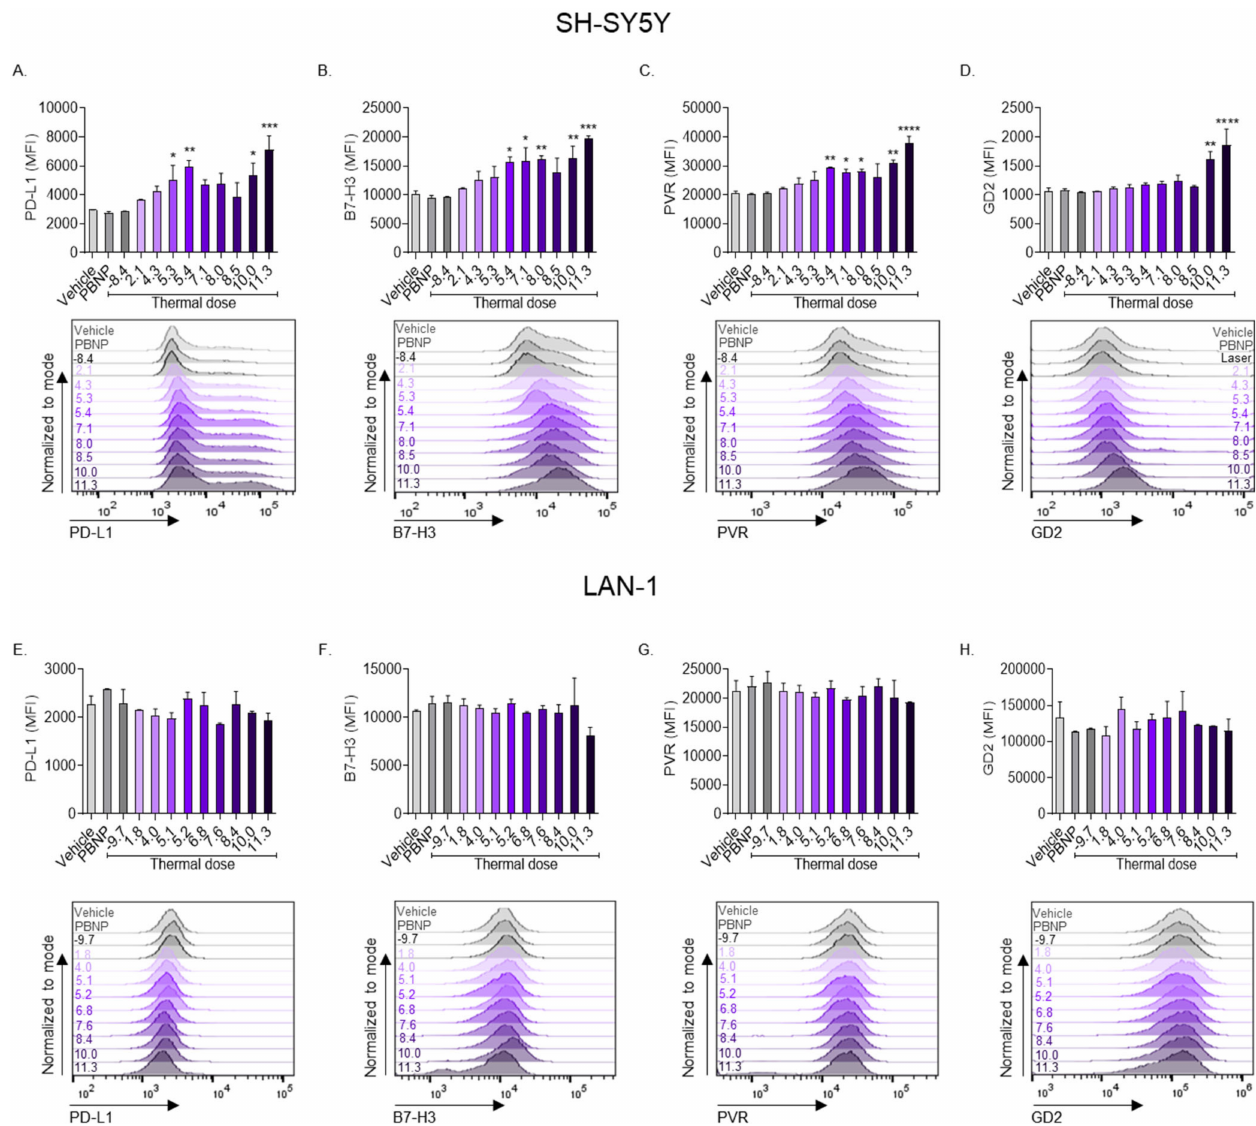
Figure 5. The effect of PBNP-PTT-administered thermal dose on immune checkpoint molecules, an NK cell-activating ligand, and a neuroblastoma-associated antigen is more pronounced in SH-SY5Y cells compared with LAN-1 cells. ( A – D ) SH-SY5Y and ( E – H ) LAN-1 cells were treated in vitro with varied thermal doses via PBNP-PTT. 24 h post-PBNP-PTT, cells were analyzed for expression of ( A , E ) PD-L1, ( B , F ) B7-H3, ( C , G ) PVR, and ( D , H ) GD2 using flow cytometry analysis. Inset values in the histograms denote the thermal dose. Each parameter was compared to the vehicle control by one-way ANOVA, where * p < 0.03, ** p < 0.002, *** p < 0.0002, **** p < 0.0001; n =